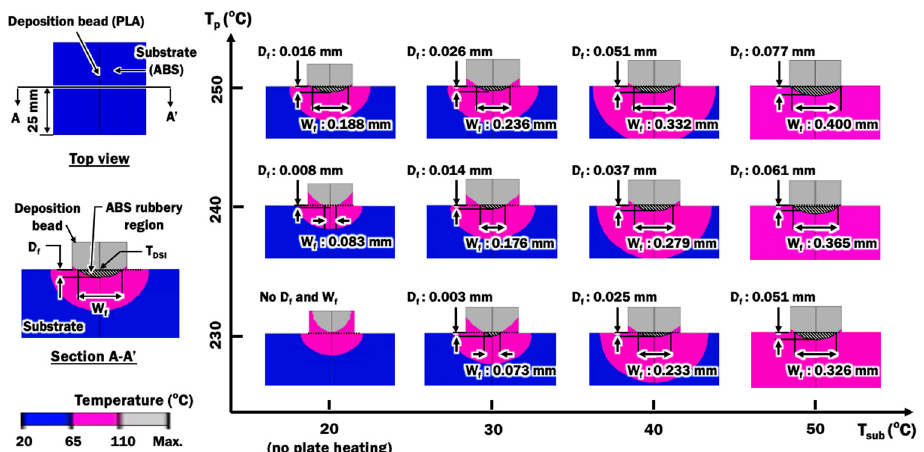
Figure 15. Estimated temperature distributions of PLA material from heat transfer analysis using different combinations of printing temperatures and extruded length of filament from the end of the nozzle orifice.